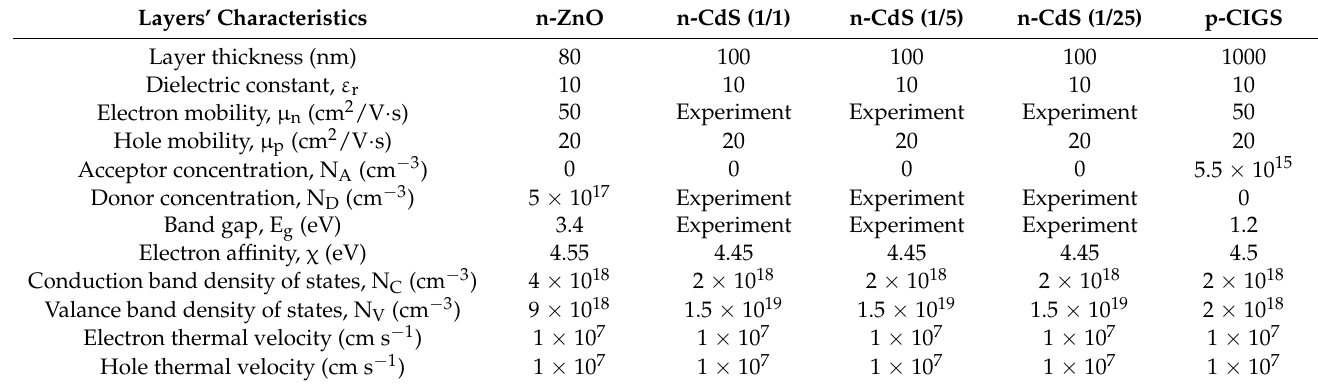
Table 2. Summary of physical and electrical characteristics for each layer parameter [32–34].